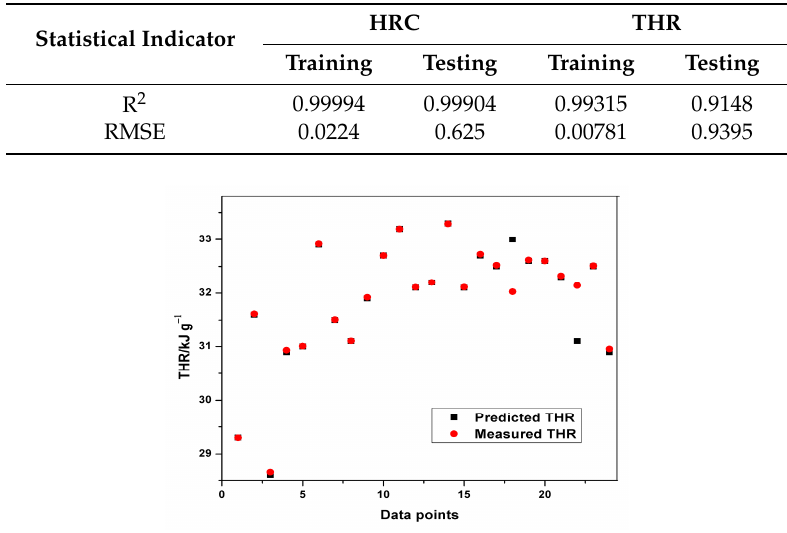
Figure 9. Plot of predicted and measured THR for training.